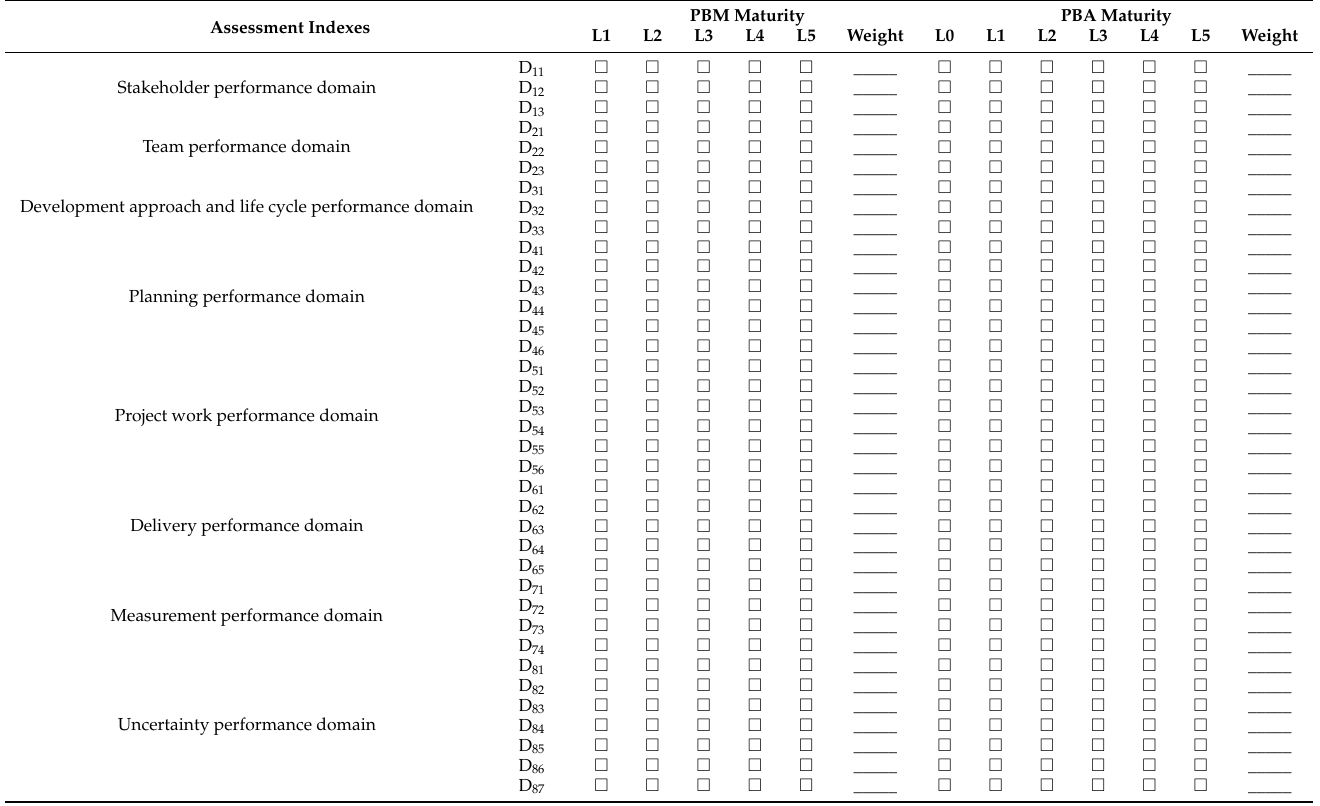
Table 3. Scoring table of BATM